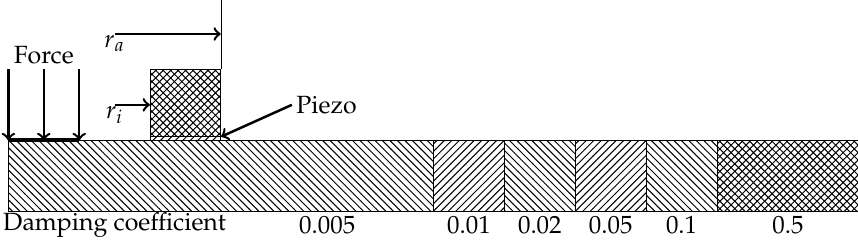
Figure 16. 2D FEM Model for simulation of wave propagation in an endless